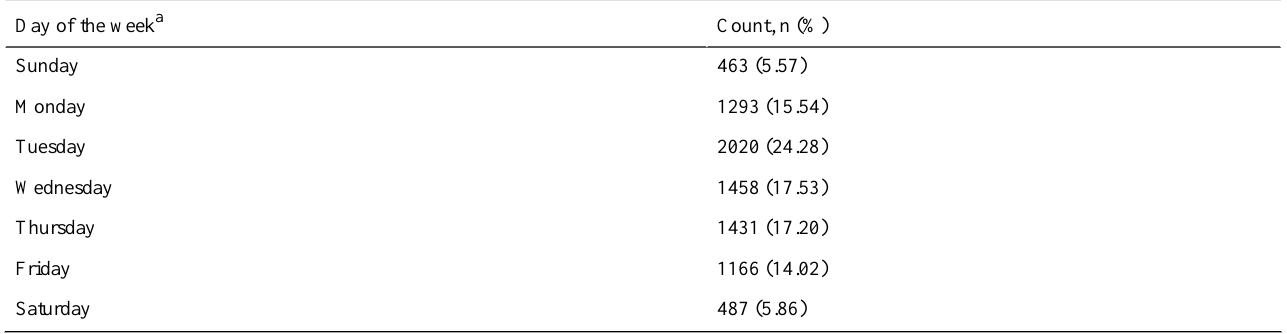
Table 2. Daily referral traffic (Salud America! website users) from Twitter (2017-2018);